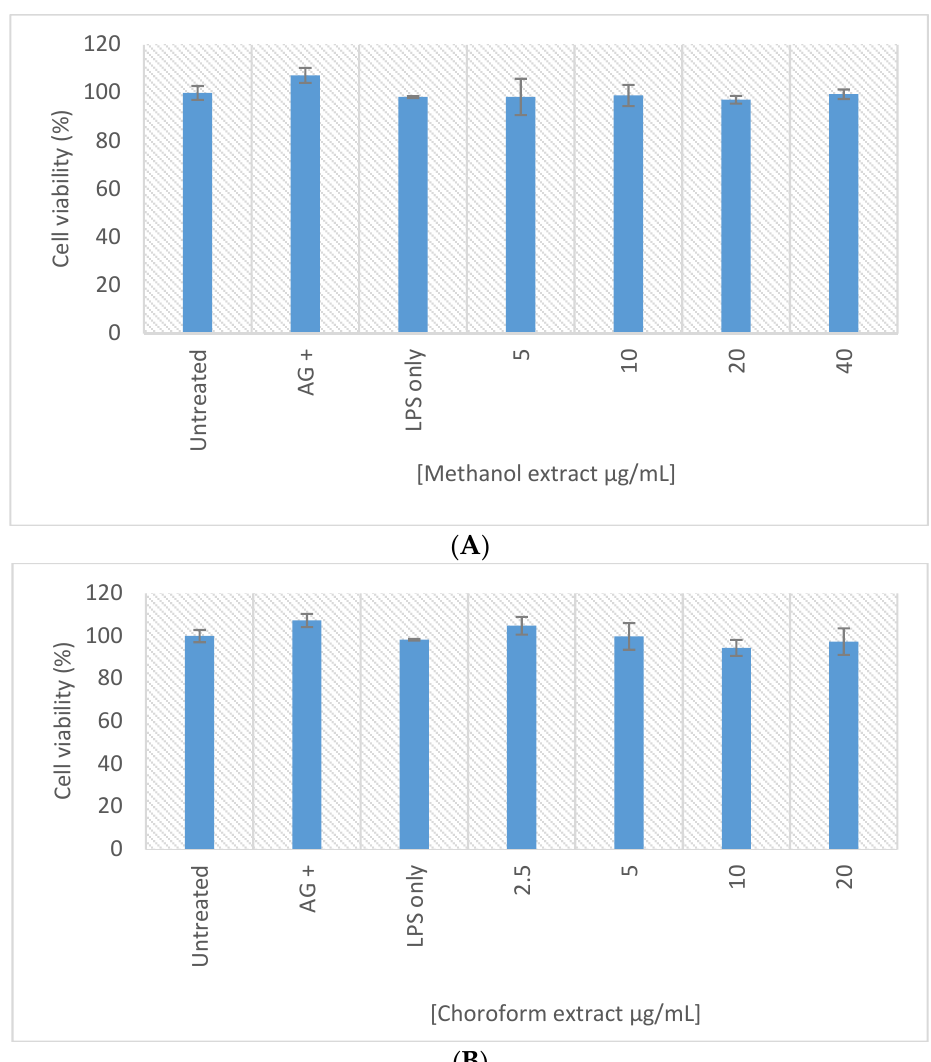
Figure 10. Cell viability (%) of the LPS activated macrophages after 24 h exposure to samples of the methanol extract ( A ) and chloroform extract ( B ). Bar graph represents the quadruplicate values of one experiment. Error bars represent the standard deviation of the mean.